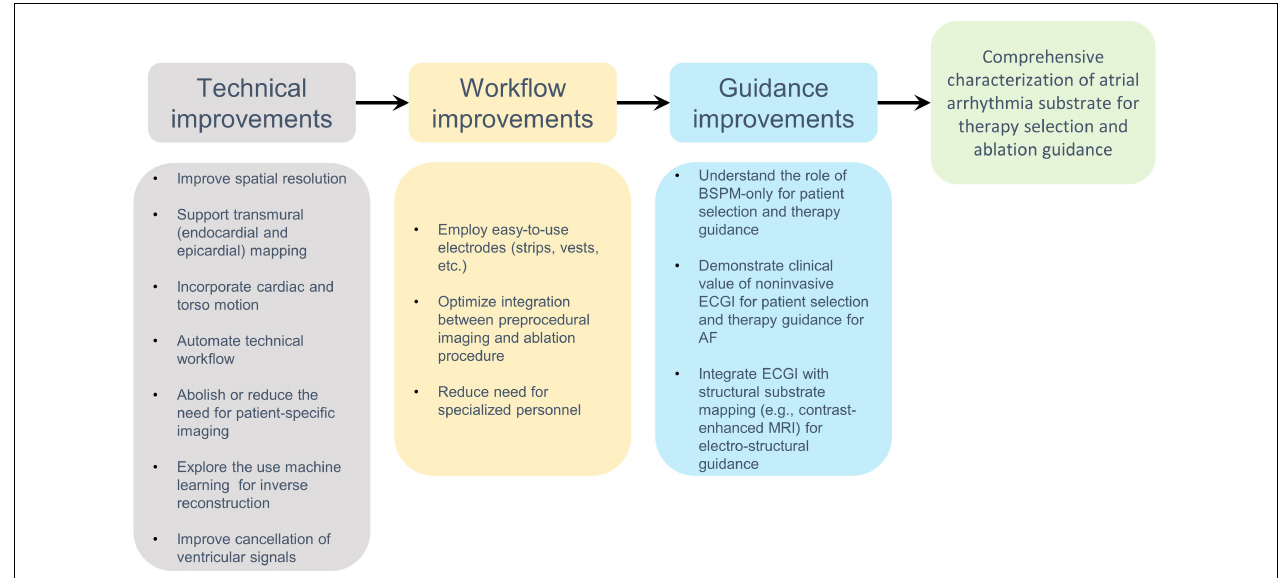
FIGURE 9 | Roadmap with future directions of Electrocardiographic imaging (ECGI) in atrial fibrillation